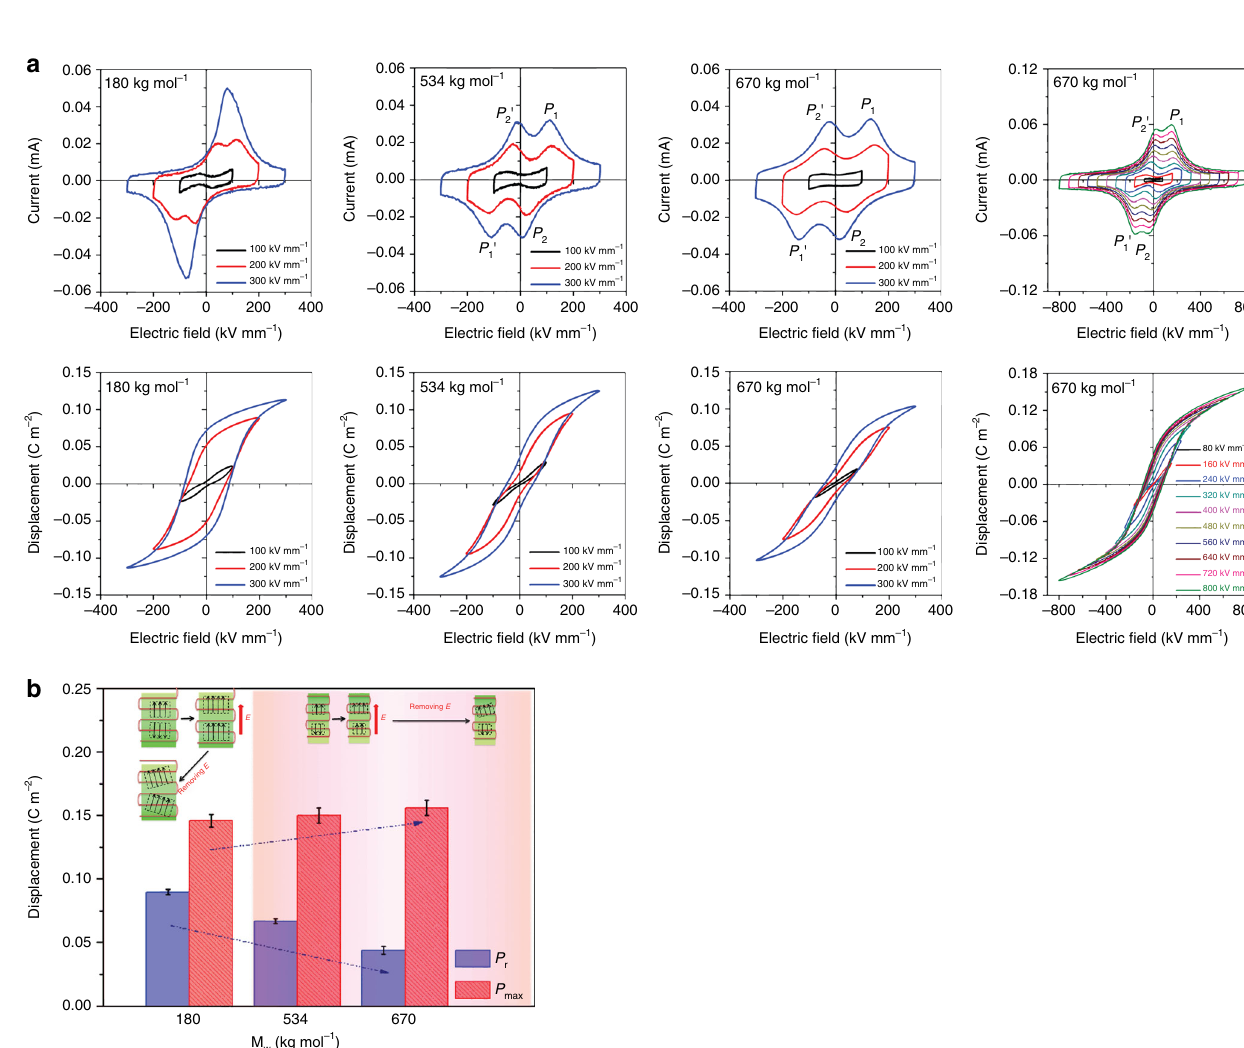
Fig. 3 Factors in fl uencing the formation of β -phase during processing. a Comparison of the phase transition in samples (670 – 700 kg mol − 1 ) with monolayer and six multi-stacked layers at three different pressures (force 300 kN), 120, 667 and 3000 MPa, followed by pressure annealing at 165 °C for 5 min, which indicates that high pressure and layered structure favour the formation of β -phase. b Fraction of β -phase for samples (670 – 700 kg mol − 1 ) with the same dimensions, but composed of different numbers of layers that were pressed once at 667 MPa (force 300 kN) followed by pressure annealing at 165 °C for 5 min and cold water quenching. c FEM simulations of fi lm compression in the cases of monolayer fi lm, four-layer fi lm with same friction coef fi cients µ between layer and platen and between layers, and four-layer fi lm with µ between layer and platen higher than µ between the layers. The bar scale represents the overall strain deformations. d FTIR of samples with different M w , which indicates the formation of γ -phase in PVDF (low M w ) at higher γ -characteristic band at 1234 cm − 1 ) and high M β -phase (inset). For PVDF with M T anneal (denoted by the w favours the transformation of w of 180, 534 and 670 kg mol − 1 , T m was 169, 172 and 172 °C, respectively. e Demonstration of phase evolution with T anneal and M w during P&F and schematic diagram of chain conformation, crystal structure and polarization of PVDF. The HP (no folding) fi lms are mainly α -phase, with two trans -gauche-trans-gauche ′ (TGTG ′ ) chains anti-parallel packed in a pseudo-orthorhombic unit cell. The symbols and arrows represent the in-plane and out-of-plane contributions to the dipole moments. After P&F at different temperatures (room temperature to T m ), fi lms formed into β -phase (>90 wt %) with all- trans (TTT) chain conformation. Low T anneal and high M w favour the formation of β -phase